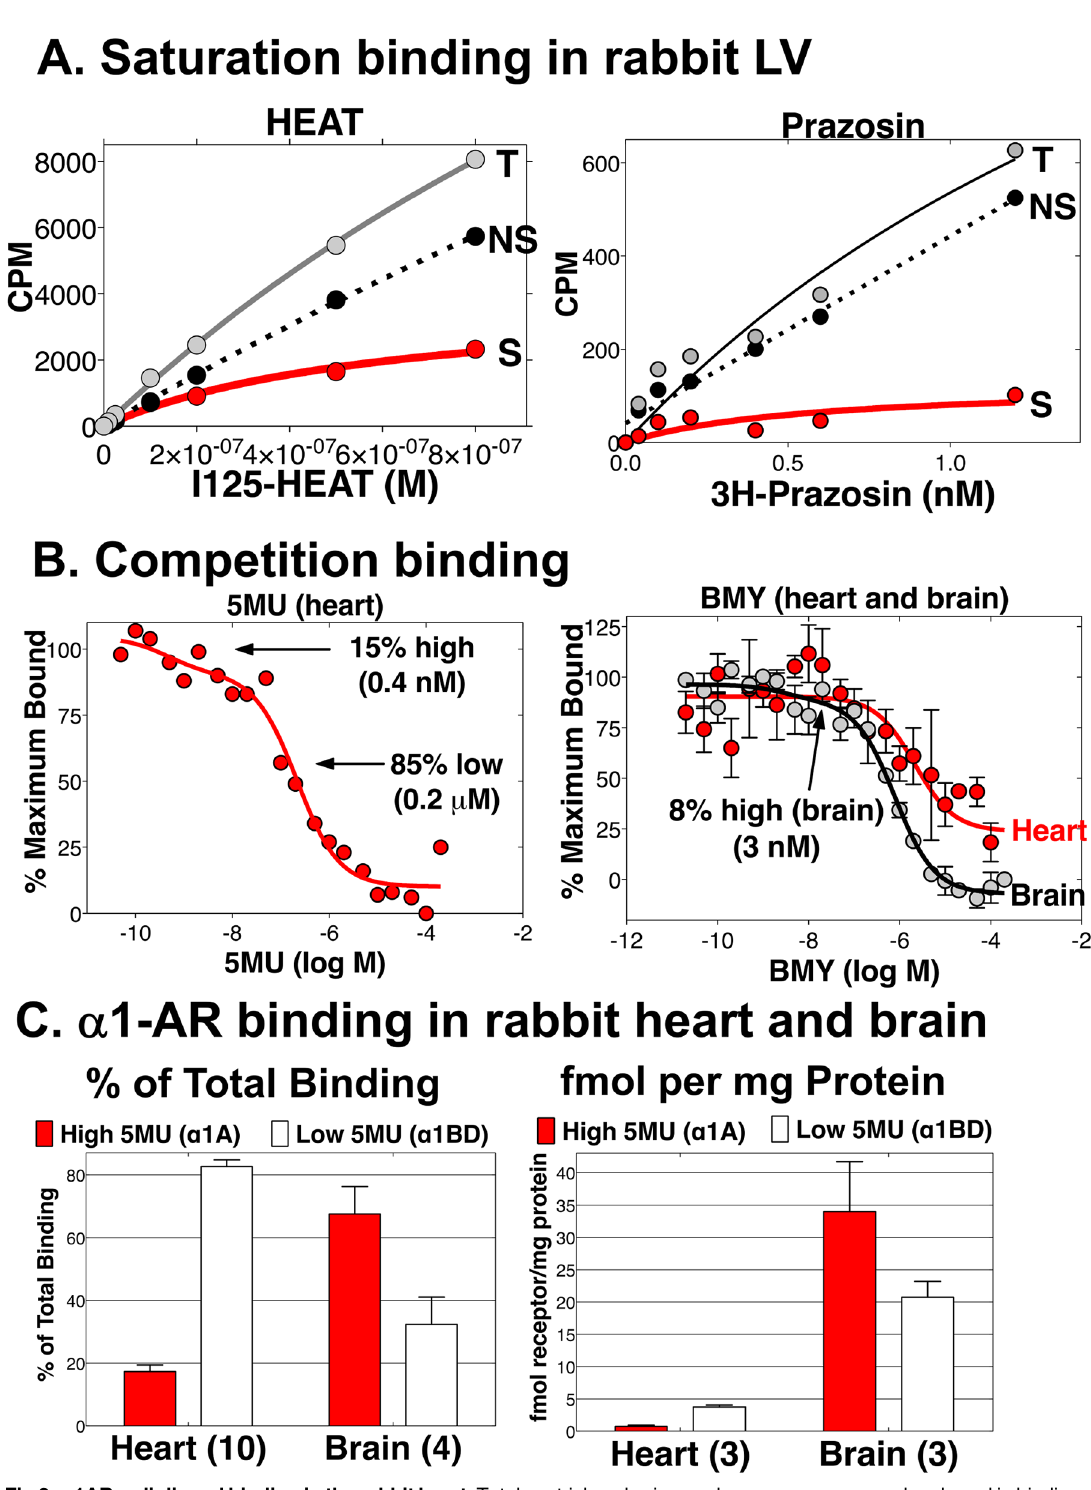
Fig 2. α 1AR radioligand binding in the rabbit heart. Total ventricle or brain membranes were prepared and used in binding assays. ( A ) Original saturation binding curves with 200 μ g heart membrane protein; left , binding with 125 I-HEAT; right , binding with 3 H-prazosin; T = total binding, NS = nonspecific, S = specific; (B) left , competition for 125 I-HEAT binding in heart with 5-methylurapidil (5MU), an antagonist with high α 1A affinity; the 2-site curve shows 15% high affinity binding; right , competition in heart, and in brain as a positive control, for 125 I-HEAT binding with BMY-7378 (BMY), an antagonist with